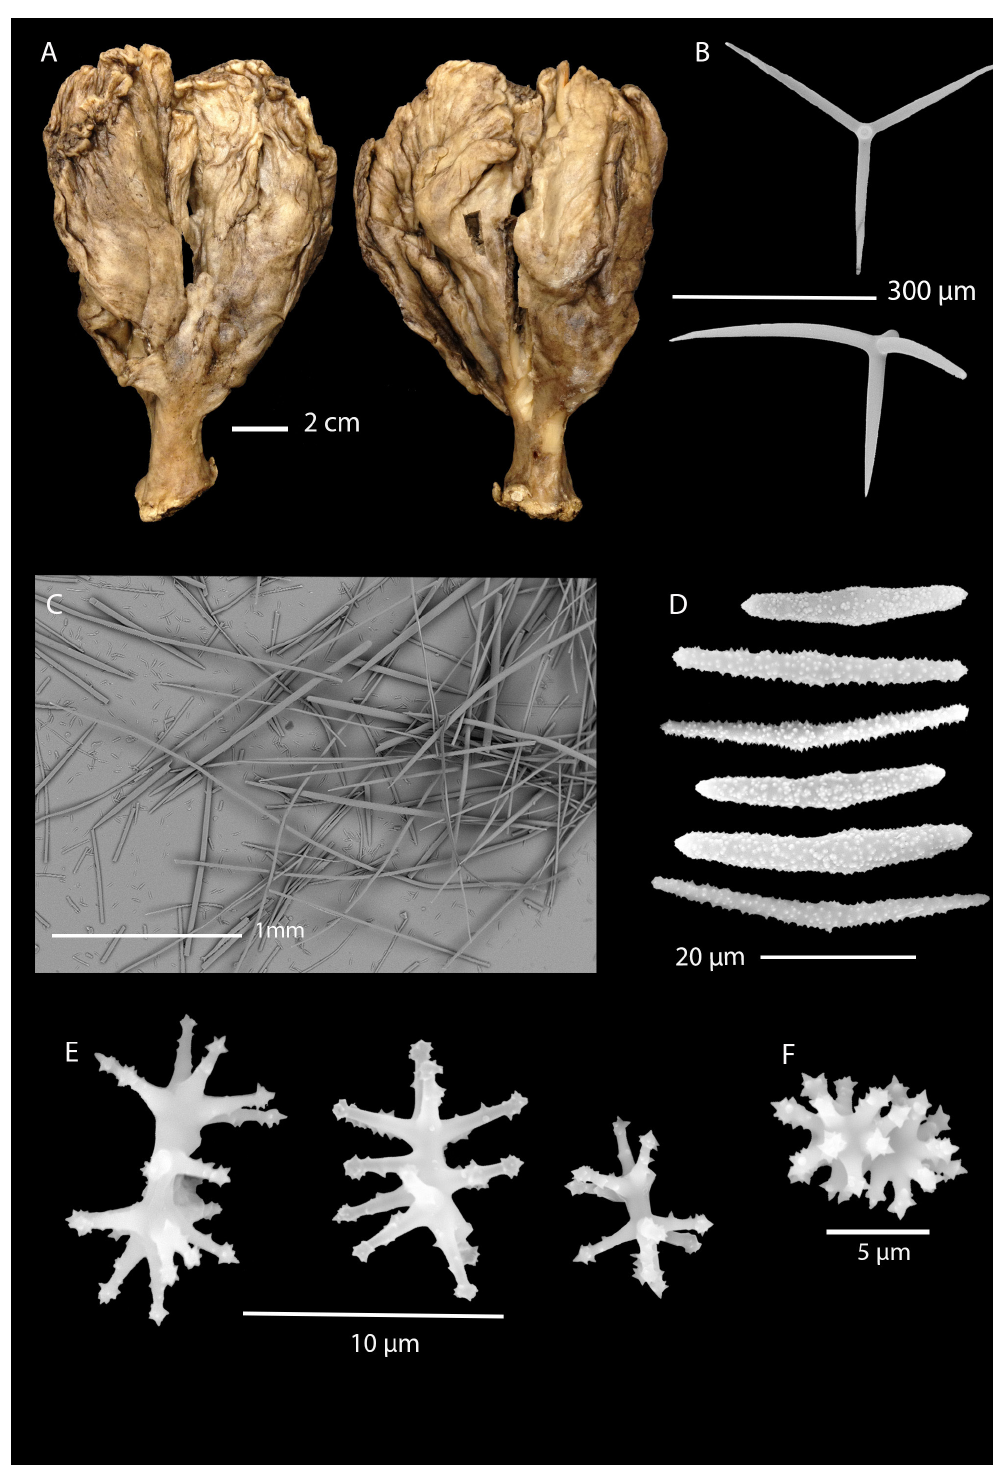
Fig. 4. Morphology, megascleres and microscleres of Poecillastra ducitriaena Kelly & Cárdenas sp. nov. (NIWA 61944 leg., holotype). A . Preserved holotype showing stalked morphology (both sides). B . Short- shafted triaenes with curved clads and short rhabd. C . Sinuous and straight oxeas. D . Microspined microxeas, sometimes faintly centrotylote, sharp ended. E . Metaster- to amphiaster-like streptasters with long, microspined rays. F . Spirasters with dense, short